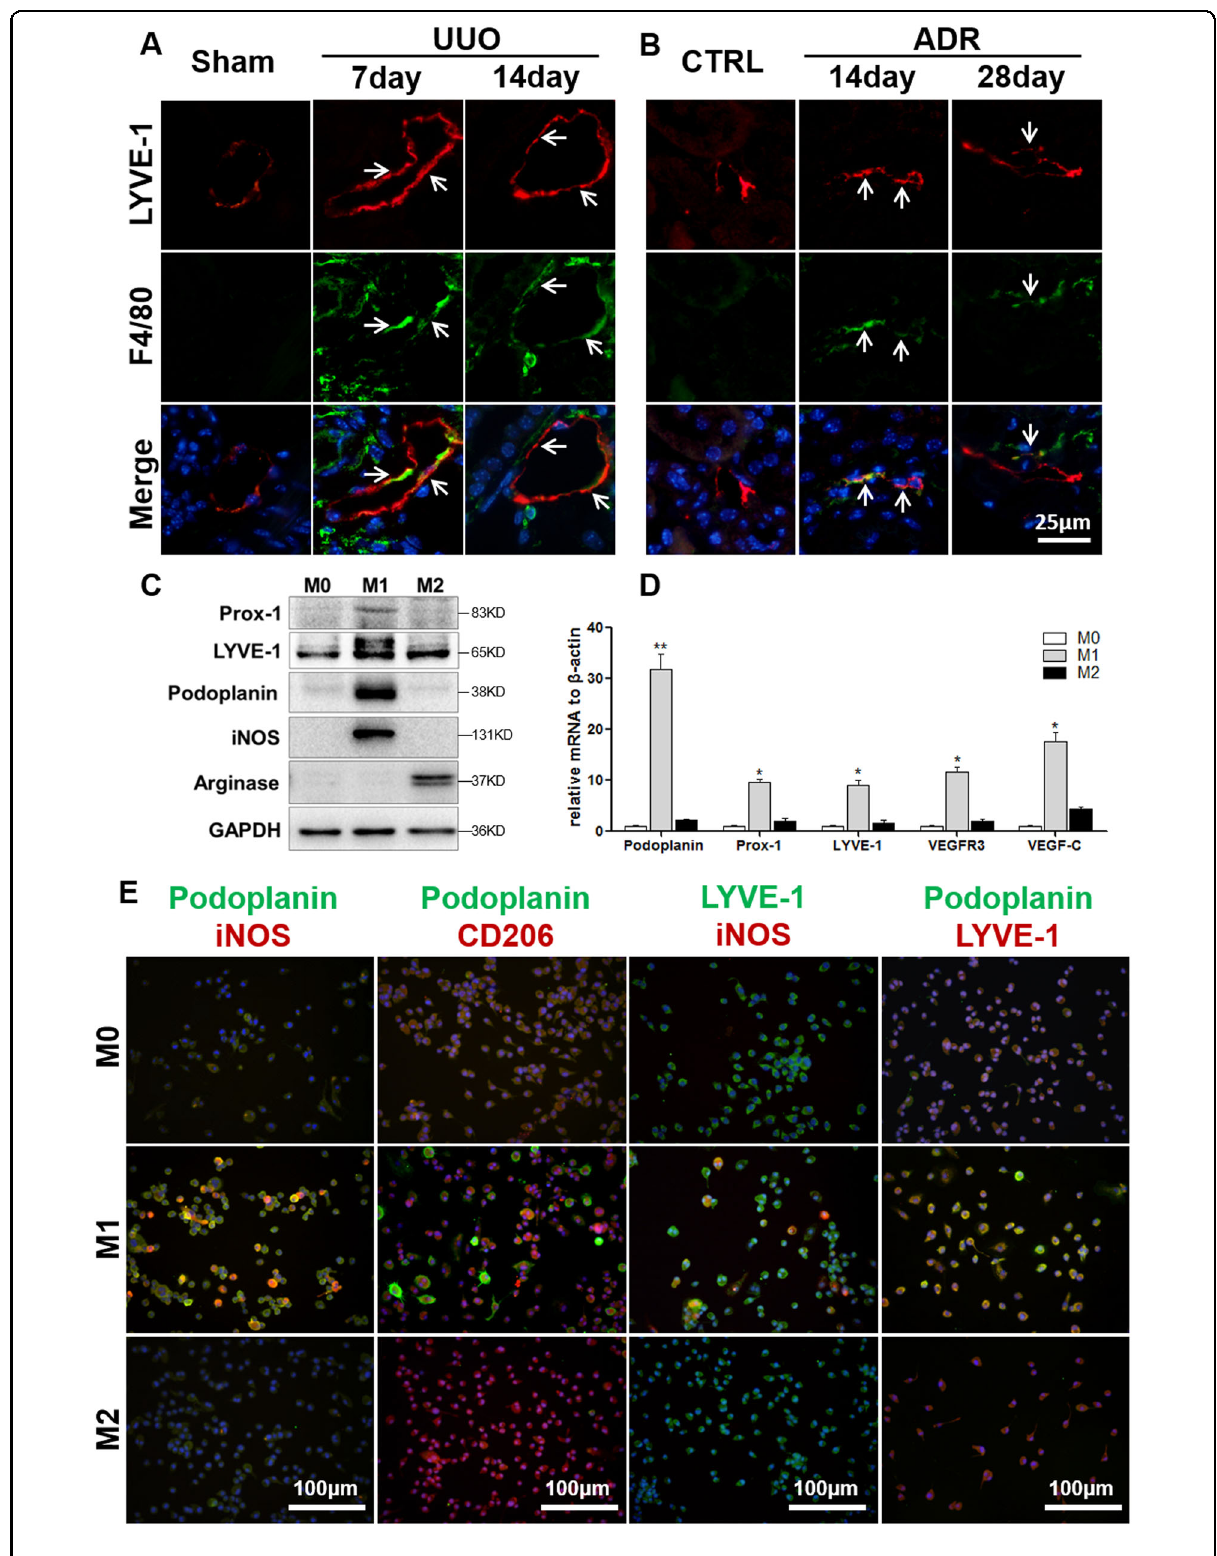
Fig. 3 (See legend on next